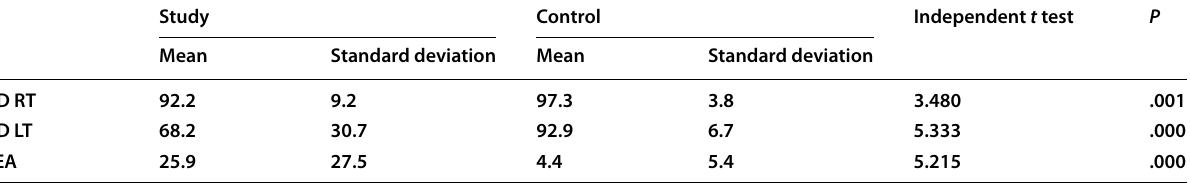
Table 5 Mean, SD, and t test of the dichotic digits test (version II) (right ear, left ear, and REA) in both study and control groups